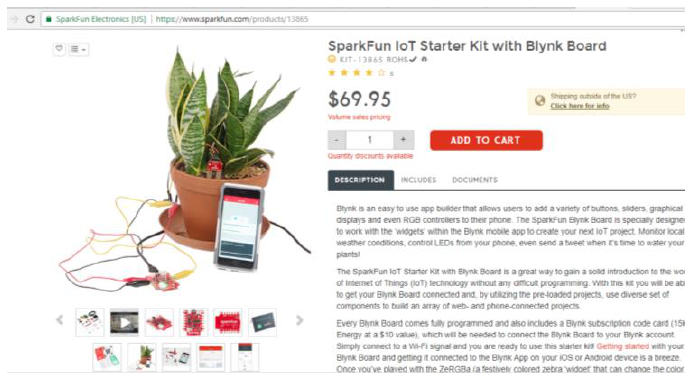
Figure 1. Diverse kinds of smart kits which make the control of the living conditions of potted plants easier (Sparkfun Website )